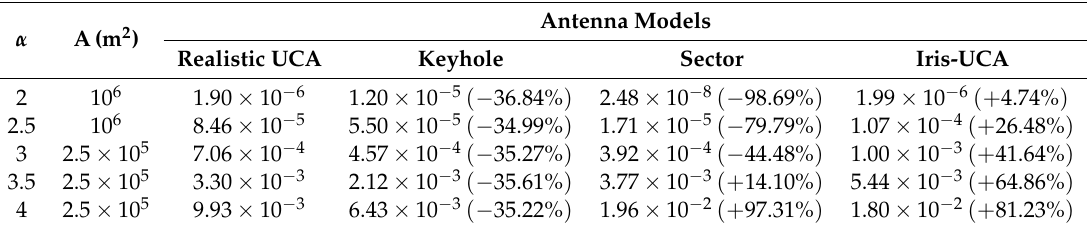
Table 6. Critical node density ρ c with UCA antenna, keyhole, sector and iris-UCA models when σ = 8. α A(m 2